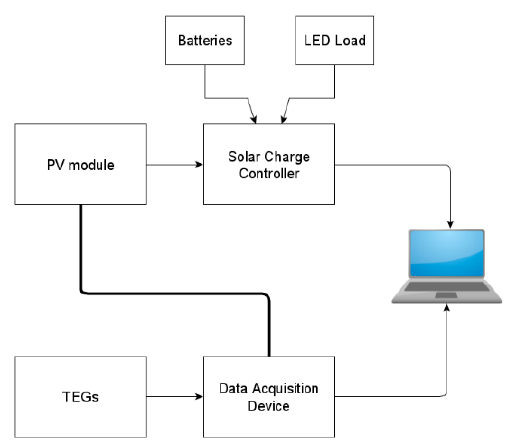
Figure 11. The setup of a PV-TEG with battery HS for indoor farming [51].